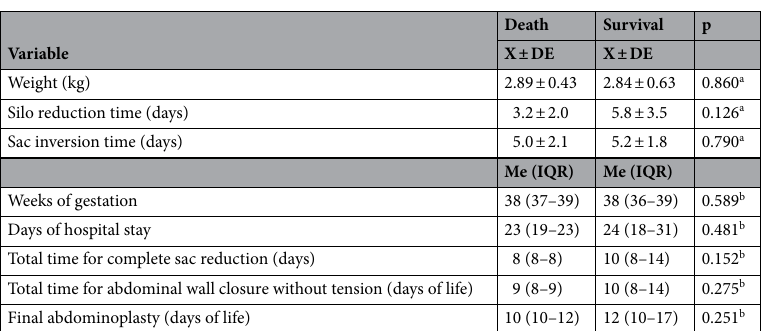
Table 4. Mortality analysis of the study subjects according to their quantitative clinical and surgical characteristics. X mean, SD standard deviation, Me median, IQR Interquartile range. a Student’s t test for independent samples with equal variances. b Mann–Whitney U